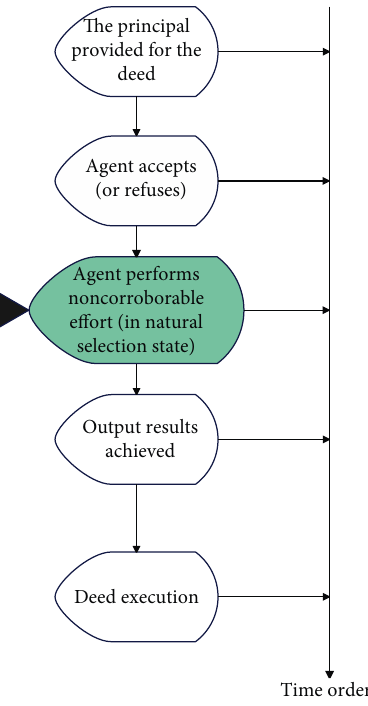
Figure 1: Emotional risk game process for hidden